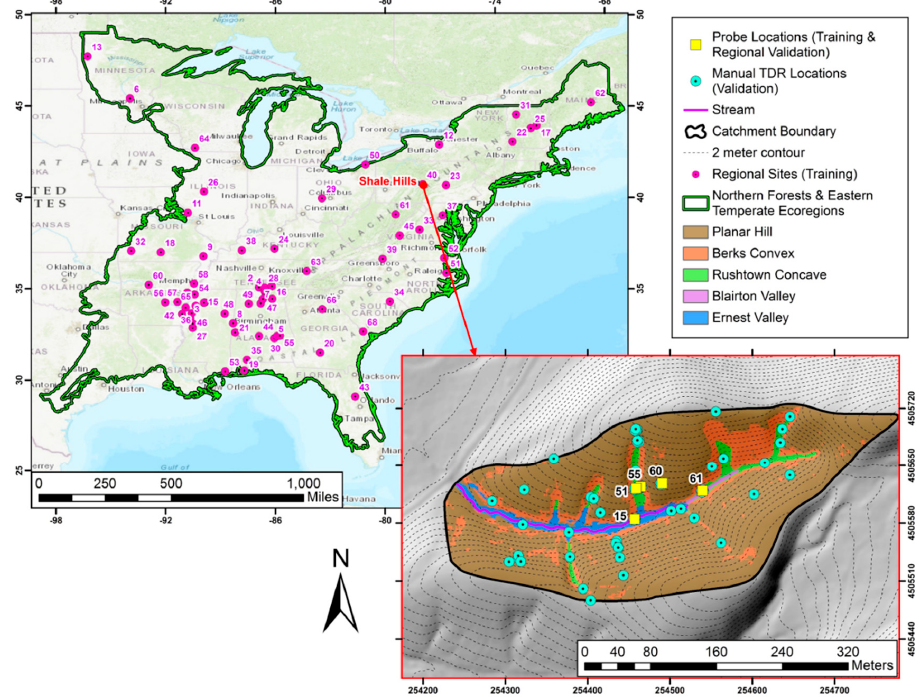
Figure 1. Map of regional study area (left), which encompasses the Eastern Temperate Forests and Northern Forests Level 1 ecoregions in the Eastern U.S. Purple points indicate Soil Climate Analysis (SCAN) and North America Fluxnet (AMERIFLUX) sites that contributed to training the regional soil moisture analytical relationship (SMAR) model in this study and corroborating its predictions at a site-level. The Shale Hills is indicated by the red point. In the enlarged Shale Hills catchment map (right), yellow squares indicate sites that are used to train the Shale Hills catchment SMAR model and cyan points indicate manual time domain reflectometry (TDR) stations where data were used for validating the Shale Hills SMAR model. Data at the yellow squares also validates the regional SMAR model.